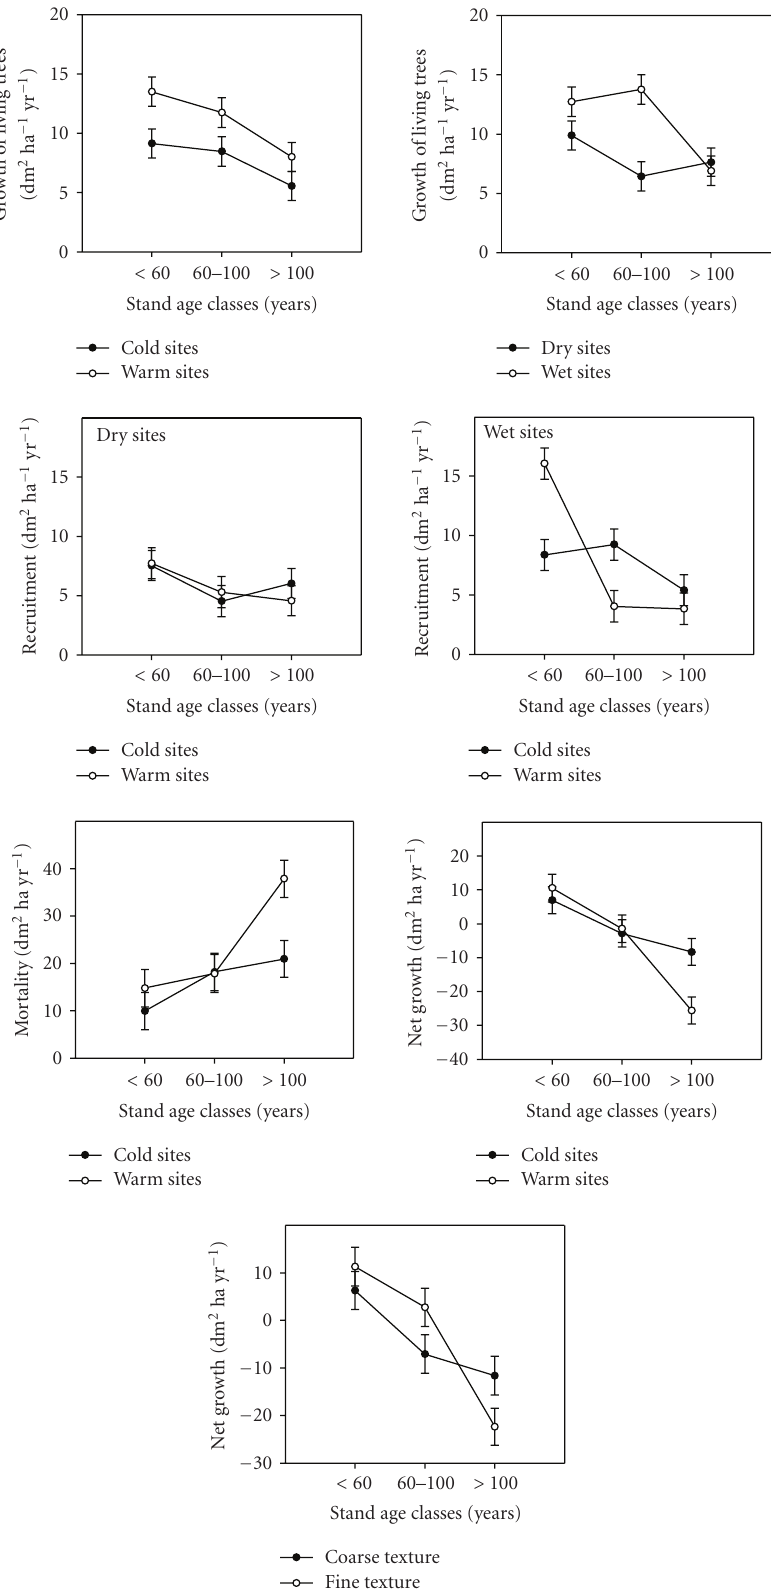
Figure 5: Relationships between parameters reflecting contemporary dynamics and stand age, air temperature, precipitation, and soil texture. Data from the two measurement periods (1970–1975 to 1978–1980 and 1990–1992 to